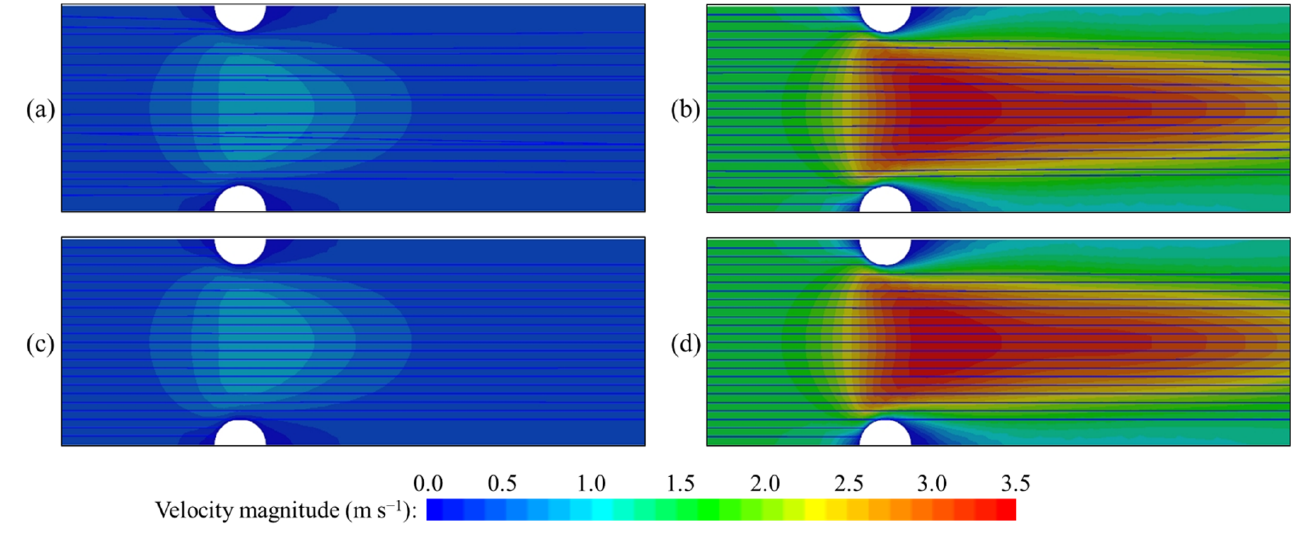
Figure 5. Velocity magnitude distribution between the screen threads (contours) and the entrained droplets’ trajectories (lines) according to the wind speed and droplet diameter: ( a ) wind speed = 1 m s -1 , droplet diameter = 40 μ m; ( b ) wind speed = 3 m s -1 , droplet diameter = 40 μ m;. ( c ) wind speed = 1 m s -1 , droplet diameter = 360 μ m; ( d ) wind speed = 3 m s -1 , droplet diameter = 360 μ m.